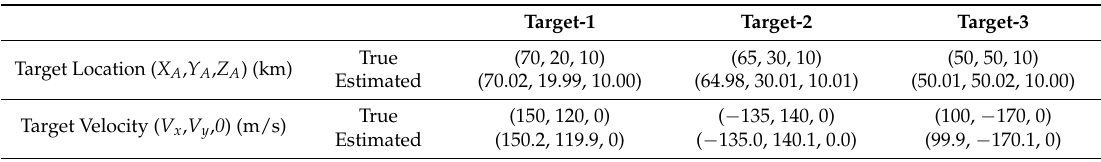
Table 3. True and estimated location and velocity of the three